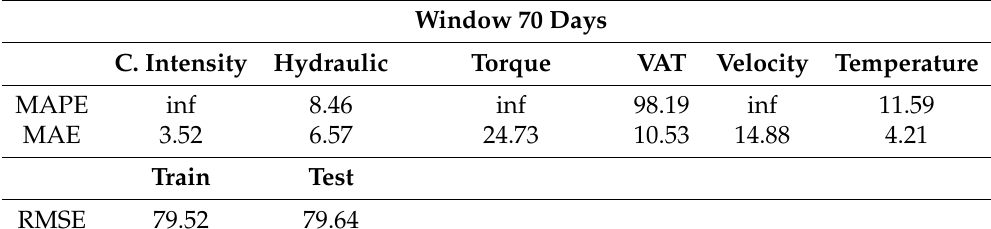
Table 2. Prediction results without cleaning discrepant data in the database, with a window of 70 samples and 40 LSTM units.